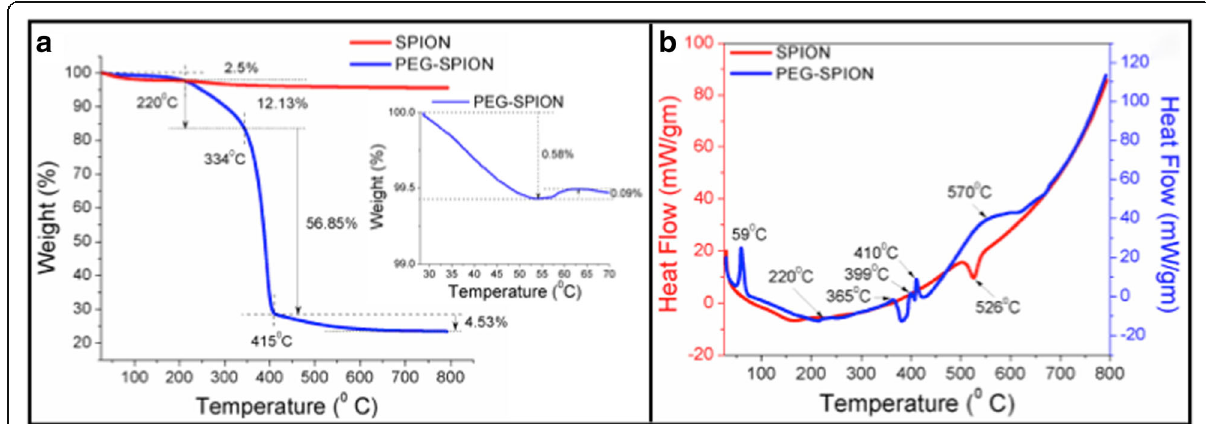
Fig. 2 a Thermogravimetric analysis curves and b differential scanning calorimetry curves of SPION and PEG-SPION. The inset shows the weight gain of